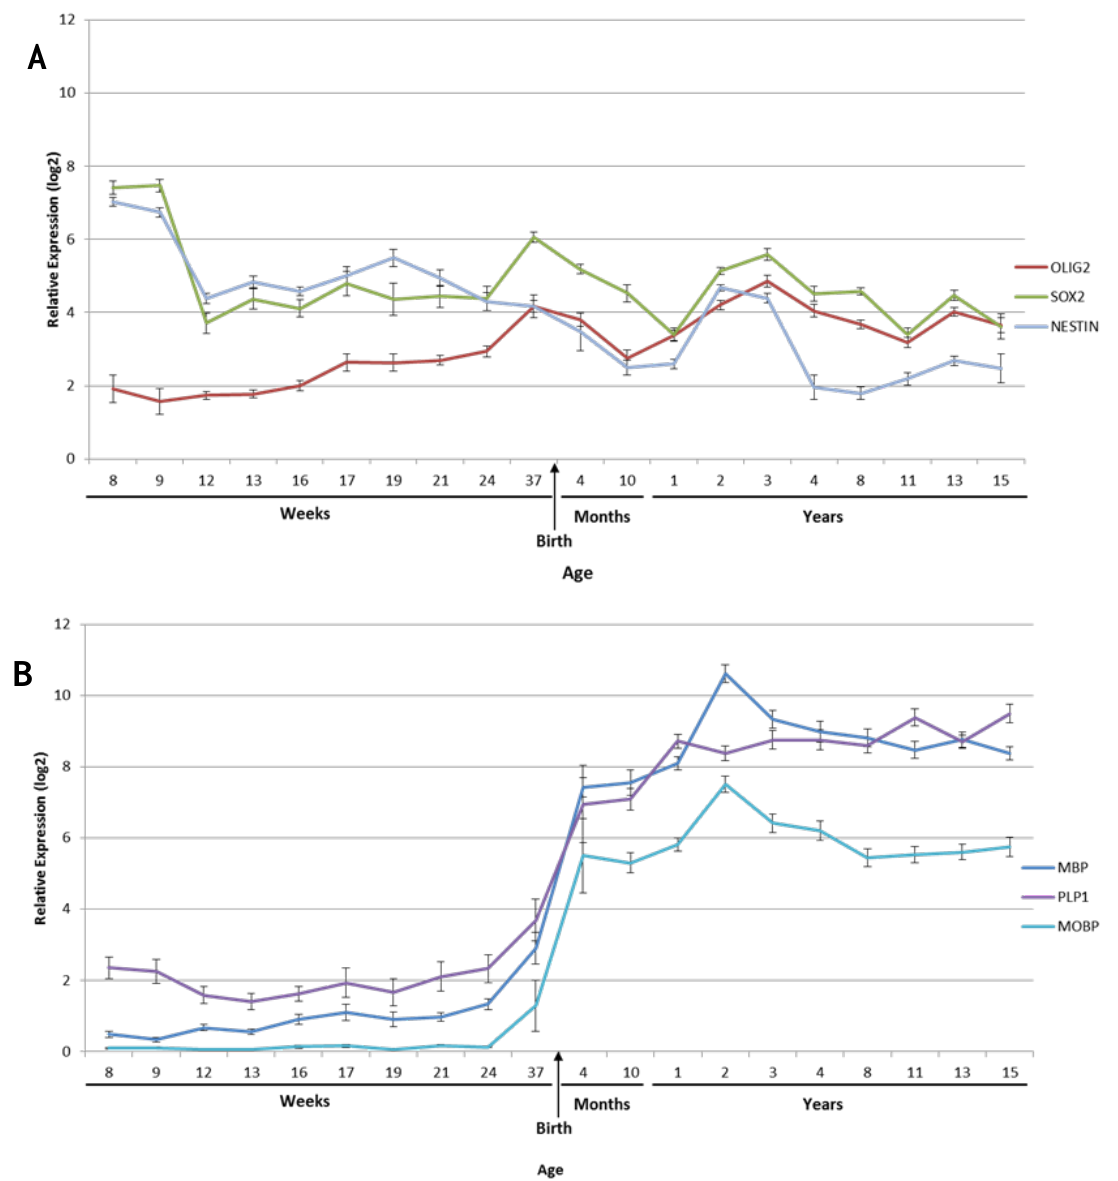
Figure 2. Timeline of genes identified in the central nervous system (CNS) development throughout development from conception to 15 years of age. Data were obtained from brainspan.org and analysed using R2. ( A ) OLIG2, SOX2, and Nestin positive cells have been identified as the main proliferating cells in early postnatal brainstem development, with a decrease around 3 years of age. ( B ) Myelinating genes show a rapid increase in expression before birth until 2 years of age, before plateauing. (Myelin Basic Protein, MBP, Proteolipid Protein, PLP1, Myelin-Associated Oligodendrocyte Basic Protein, MOBP)